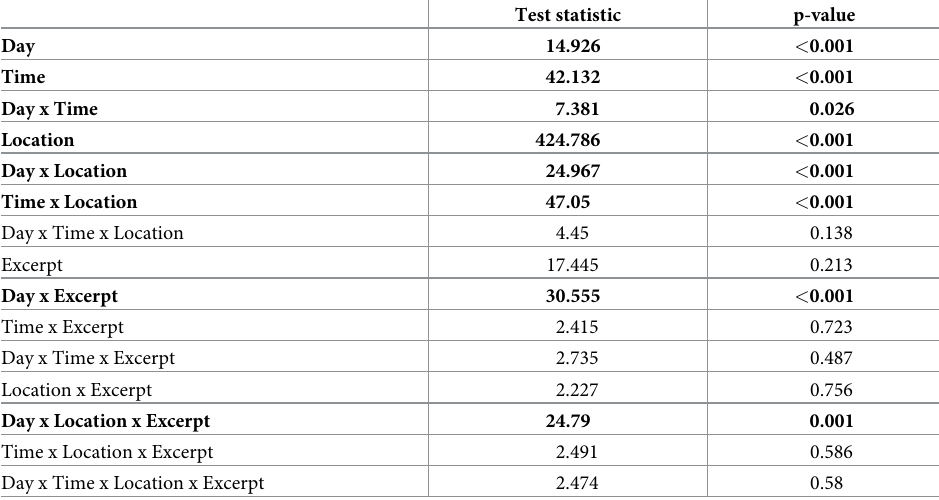
Table 7. Modified ANOVA-type statistics (MATS) and their resampled p-values (wild bootstrap– 1,000 itera- tions) for RM MANOVA over all scales (N = 544).